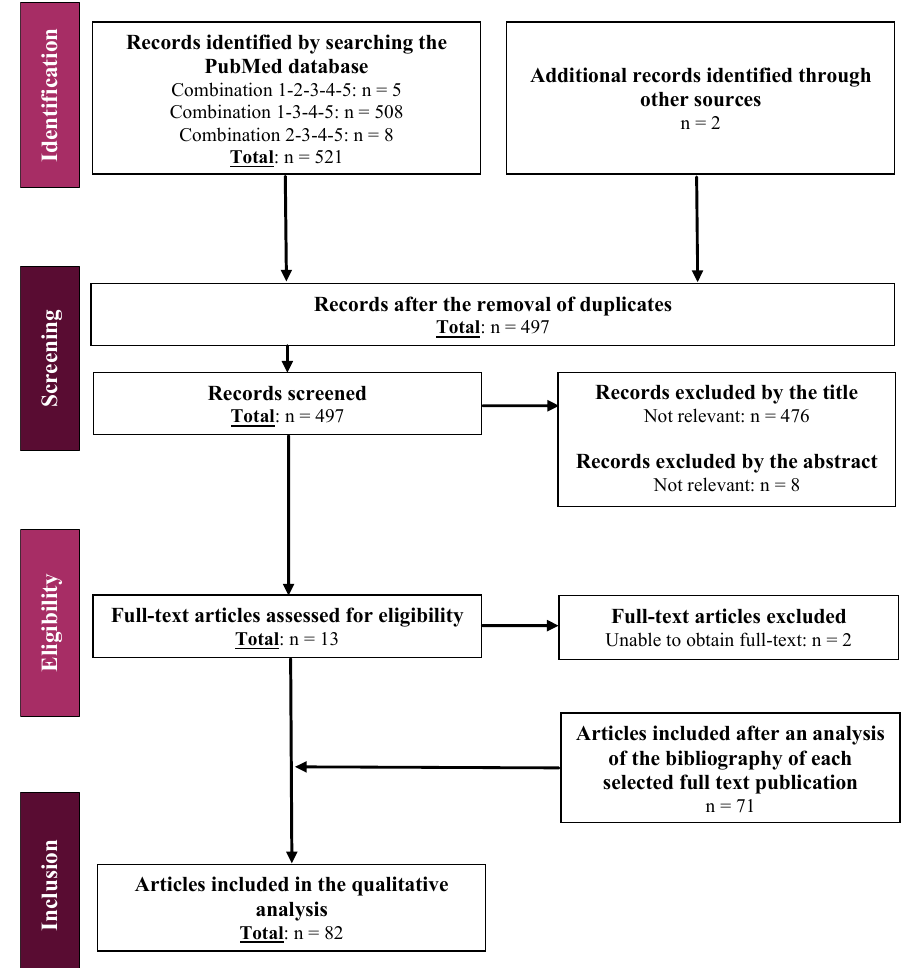
Figure 3. Flow chart for the literature search and review.